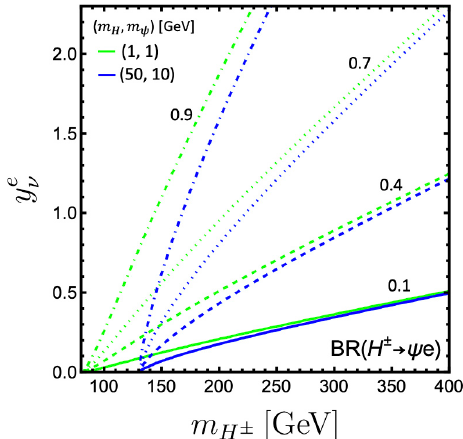
Figure 3 . Contours for BR( H ± → ψe ± ) with two benchmark values of m H and m ψ . The solid, dashed, dotted and dash-dotted lines correspond to BR ( H ± → ψe ± ) = 0 . 1 , 0 . 4 , 0 . 7 and 0 . 9 , respectively. See the text for further